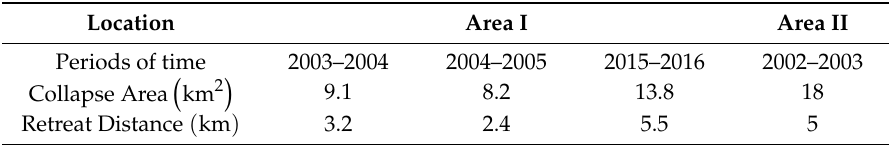
Figure 13. The location change of the calving front of 79NG ice shelf shown in the base map of Landsat 7 image data in 2012. Area A and B are the two main outlets of 79NG ice shelf, where the yellow (Area I) and green (Area II) rectangular boxes indicate that a large disintegration event has occurred in this area. The di ff erent color curves represent the position of the calving front of the ice shelf in di ff erent years. In these colored lines, the solid lines represent the major calving events that did not occur during the year, and the dotted lines represent the major calving events that occurred during the year. Table 2. Collapse area and retreat distance at 79NG ice shelf calving